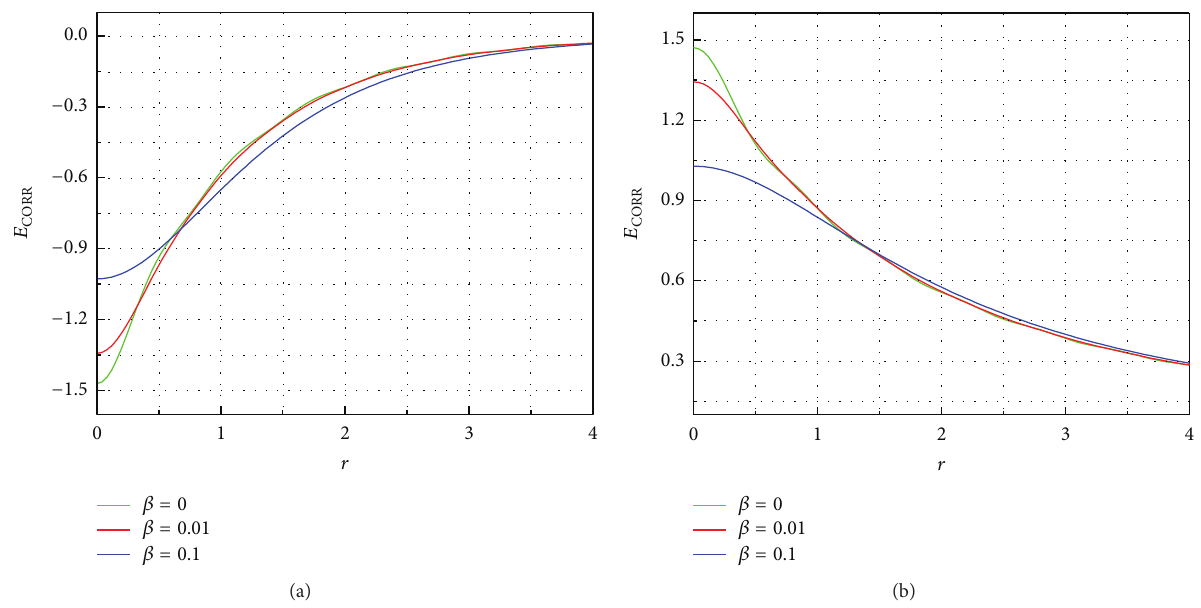
Figure 2: Real part (a) and norm (b) of 𝐸